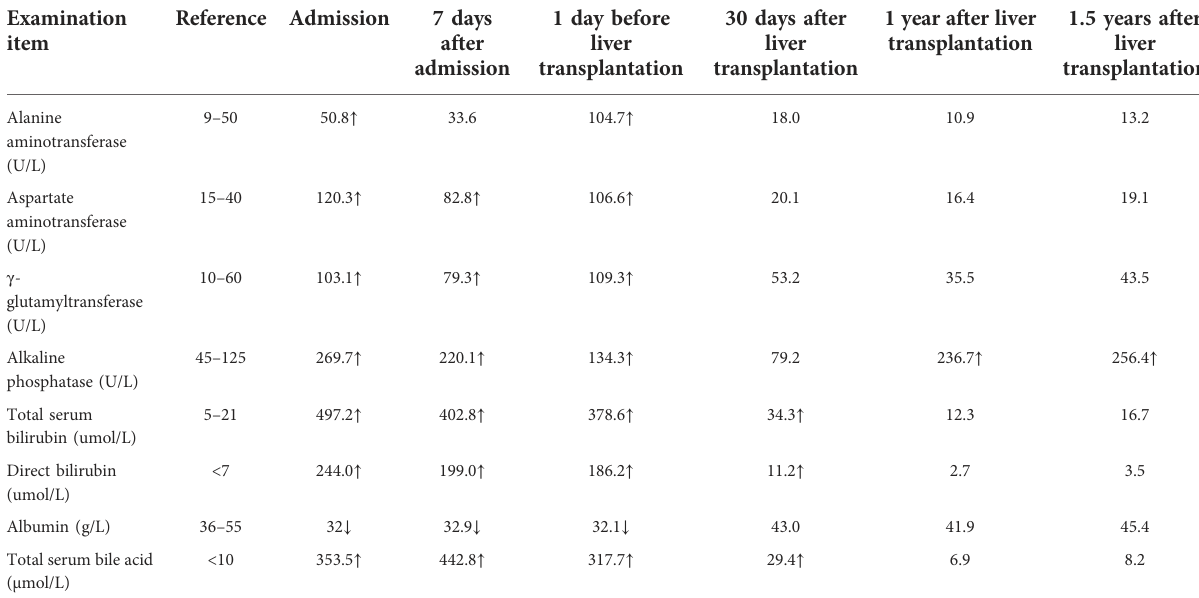
TABLE 1 Dynamic changes of his liver test of the